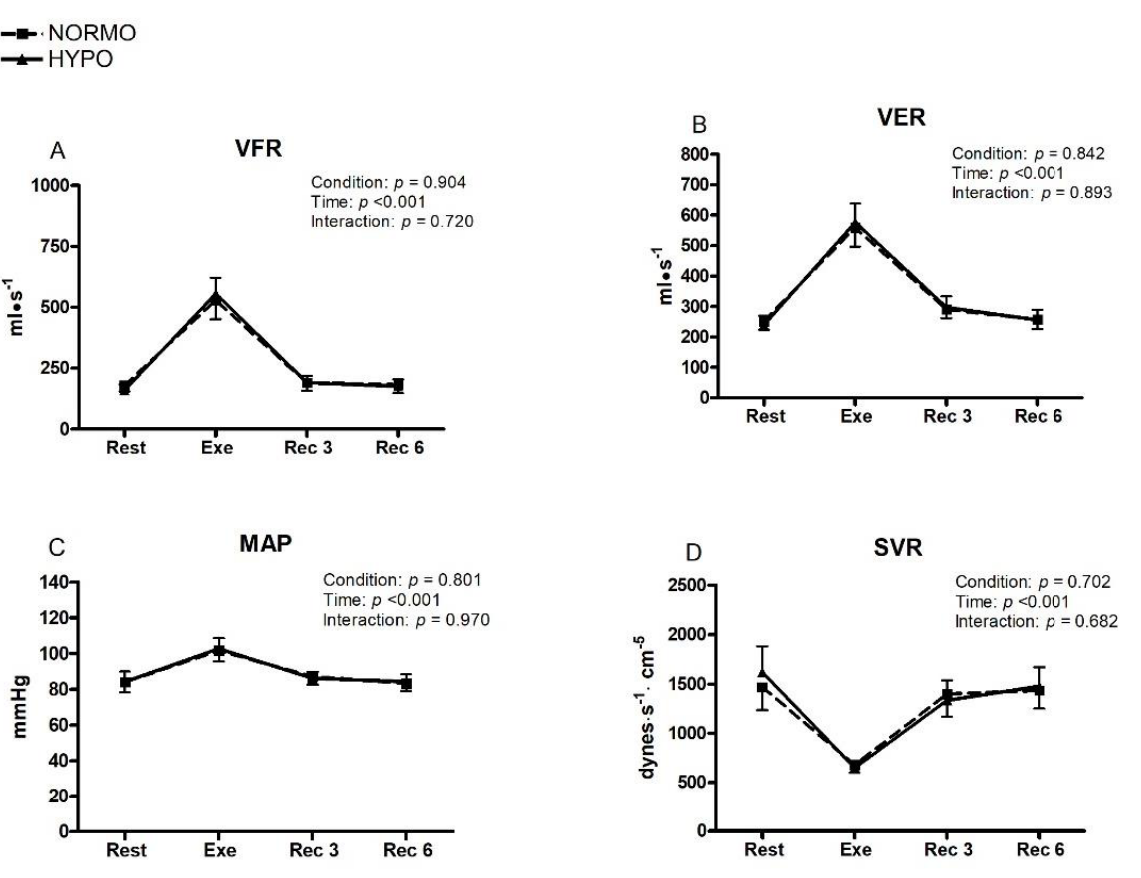
Figure 5. Changes in the level of ventricular filling rate (VFR, panel A ), ventricular emptying rate (VER, panel B ), mean arterial pressure (MAP, panel C ), and systemic vascular resistance (SVR, panel D ) during the sessions of exercise in normoxia (NORMO) and in normobaric hypoxia with a FiO 2 of 13.5% (HYPO). Values are mean with 95% confidence interval. N = 22.